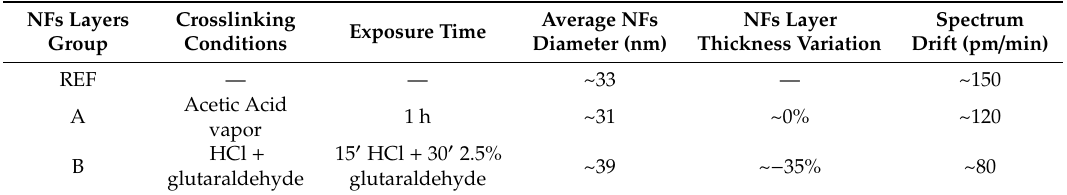
Table 1. Crosslinking conditions and morphological evaluation of NFs layers after the chemical treatments.